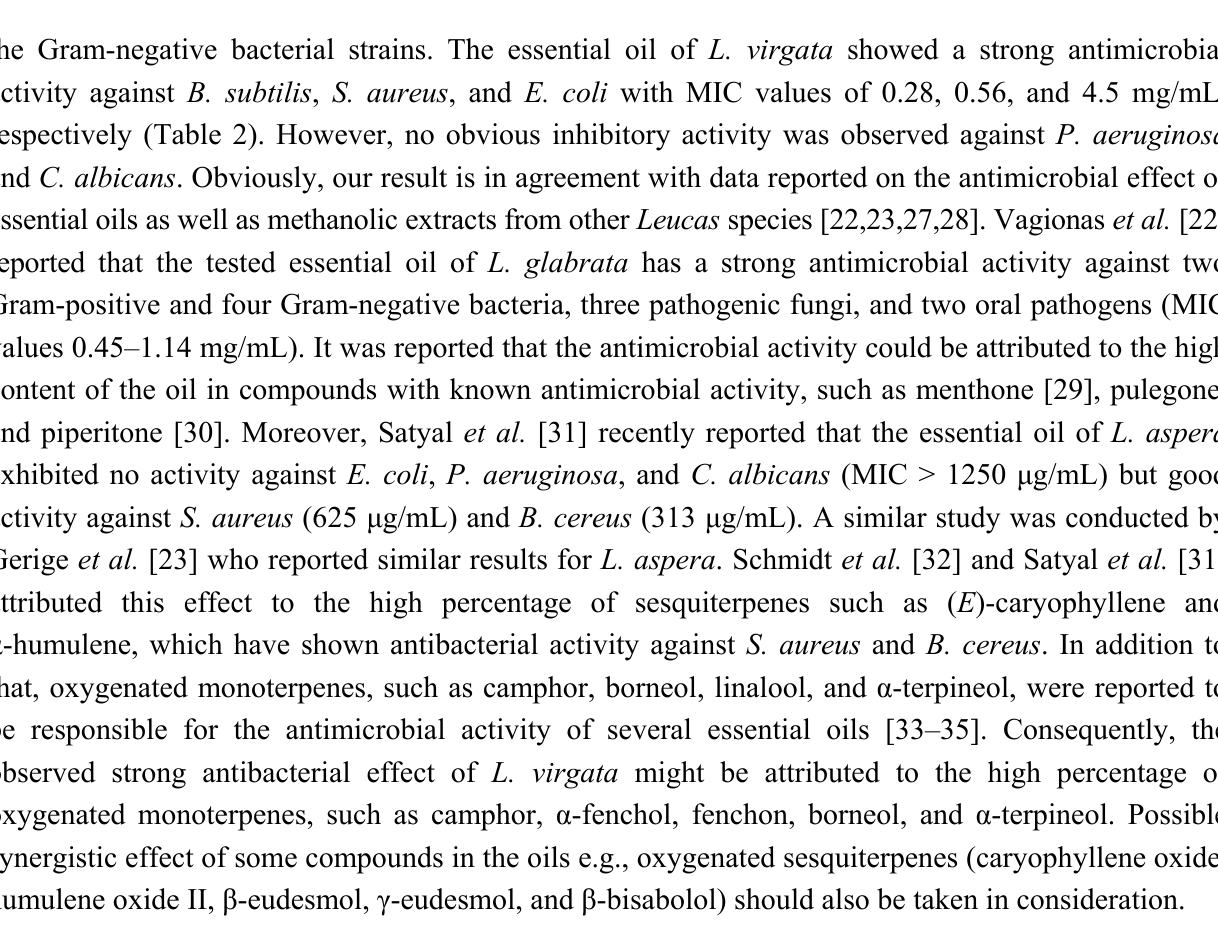
Table 2. Antimicrobial activity (minimum inhibitory concentration (MIC)-values) and free radical scavenging activity of the investigated essential oil of L. virgata